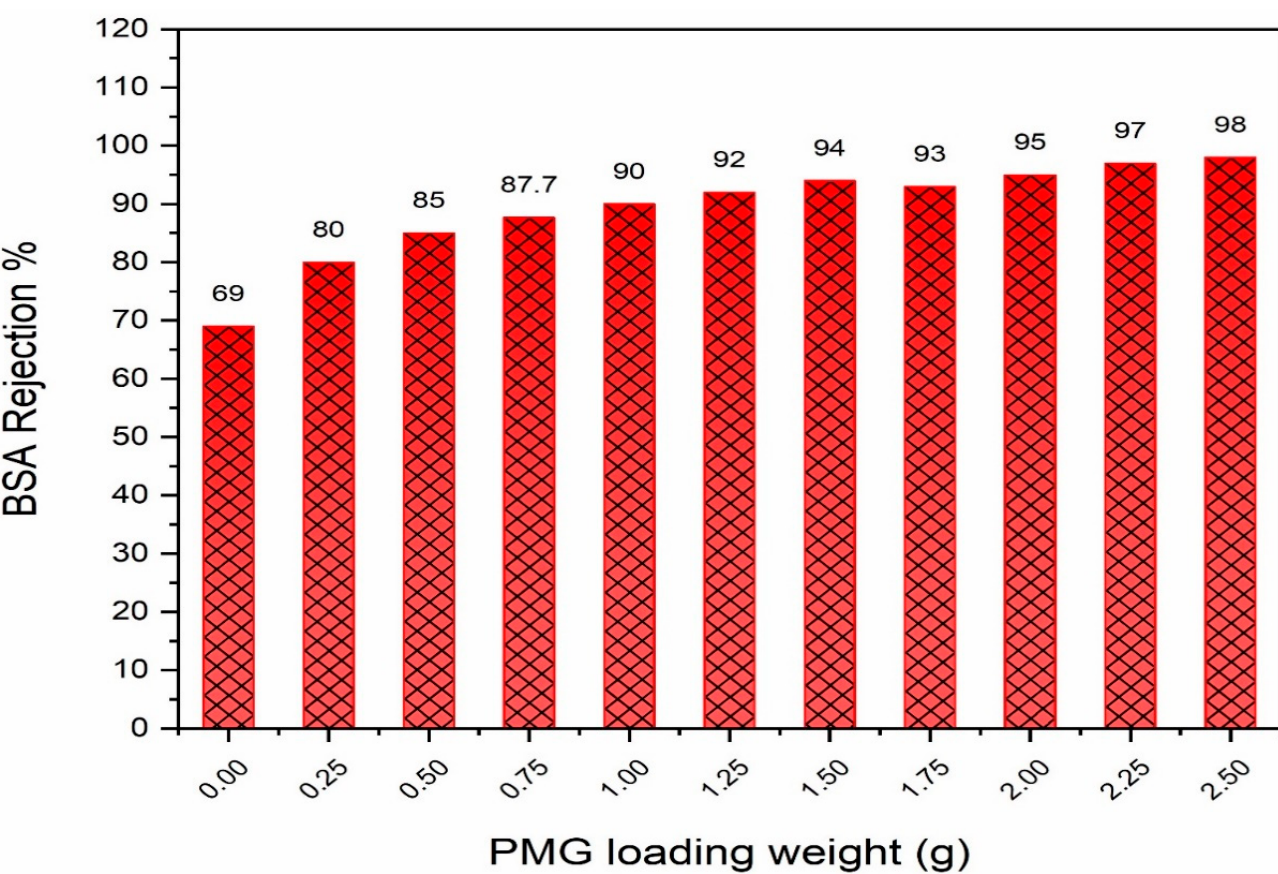
Figure 13. Retention rate of PMG nanocomposite membranes against BSA solution .